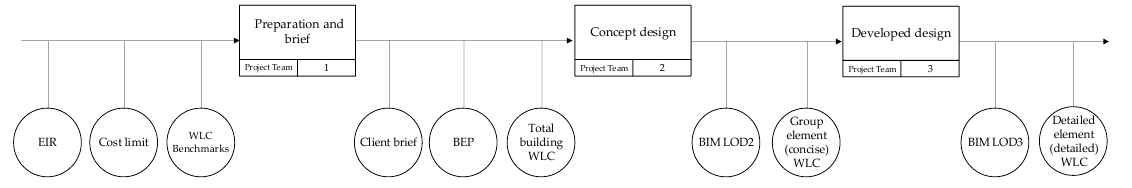
Figure 4. High-level (Level 1) IDEF3 process model (RIBA stages 1–3).